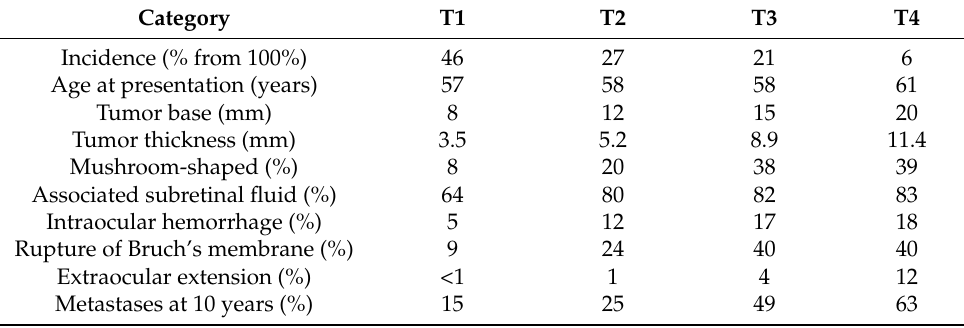
Table 2. Clinical characteristics of T1–T4 choroidal